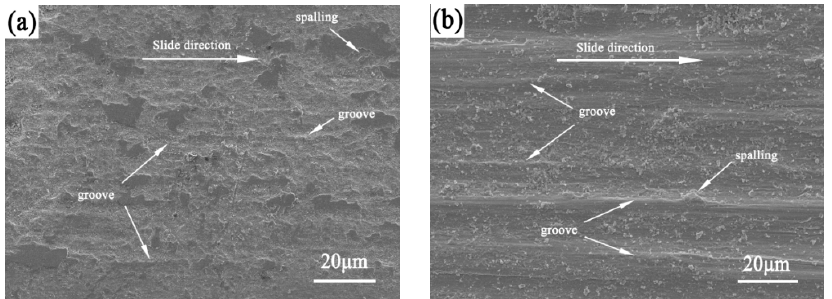
Figure 16. The worn surface morphologies of the composite coating and substrate: ( a ) composite coating; ( b ) substrate.